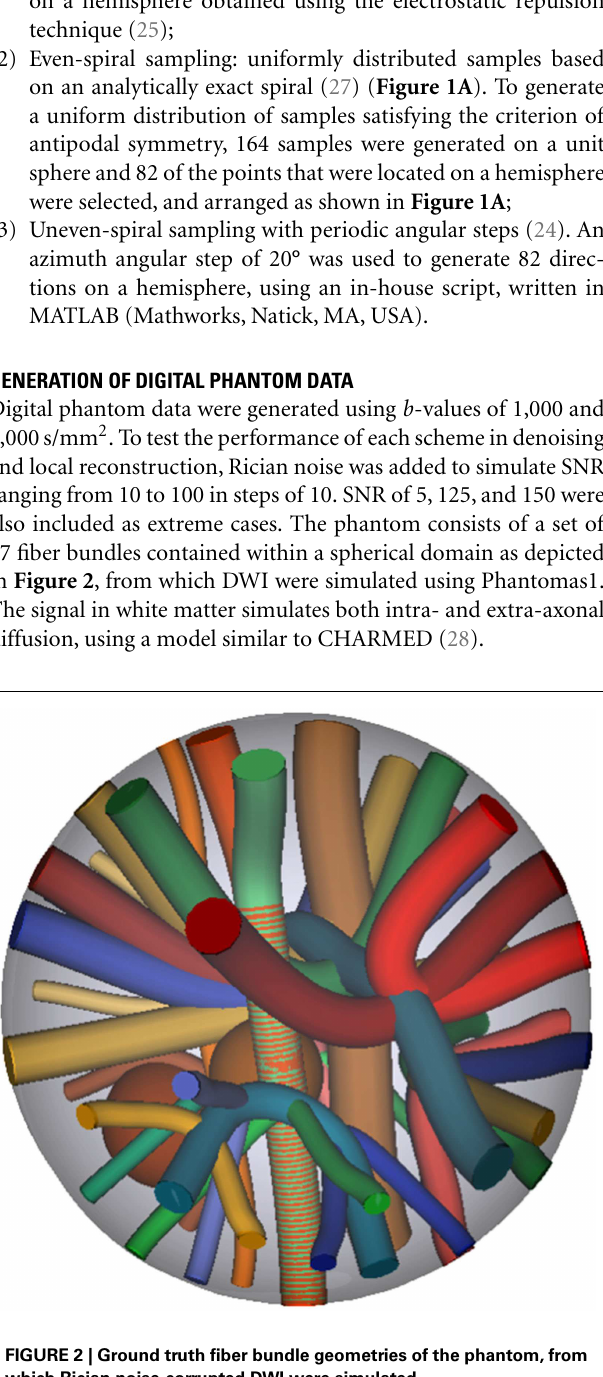
FIGURE 2 | Ground truth fiber bundle geometries of the phantom, from which Rician noise-corrupted DWI were simulated